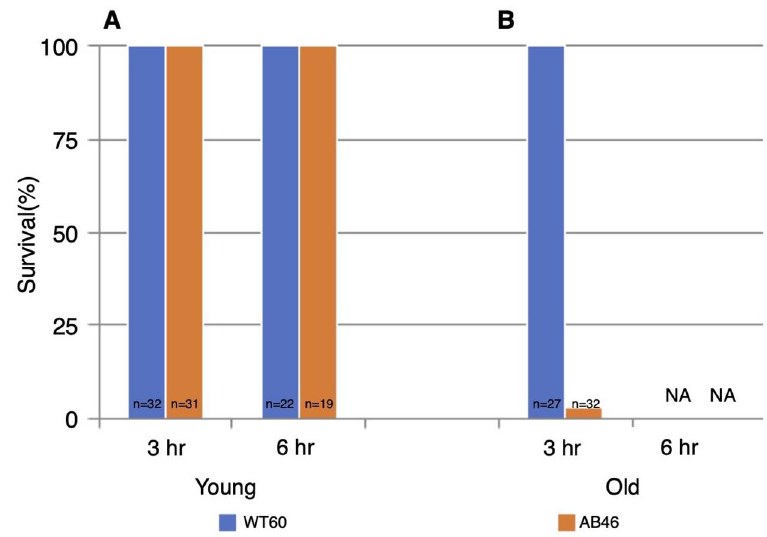
Figure 6. Survival following prolonged hypoxia . Young flies ( A ) or old flies ( B ) were subjected to either 3 h or 6 h of anoxia using a 25 mL/s flow rate of nitrogen. Flies were then returned to standard atmosphere and monitored for recovery from the spreading depression coma as described in the legend of Figure 2. Animals that did not recover movement within 5 h were scored as not surviving the hypoxia. NA indicates that none of the animals survived.